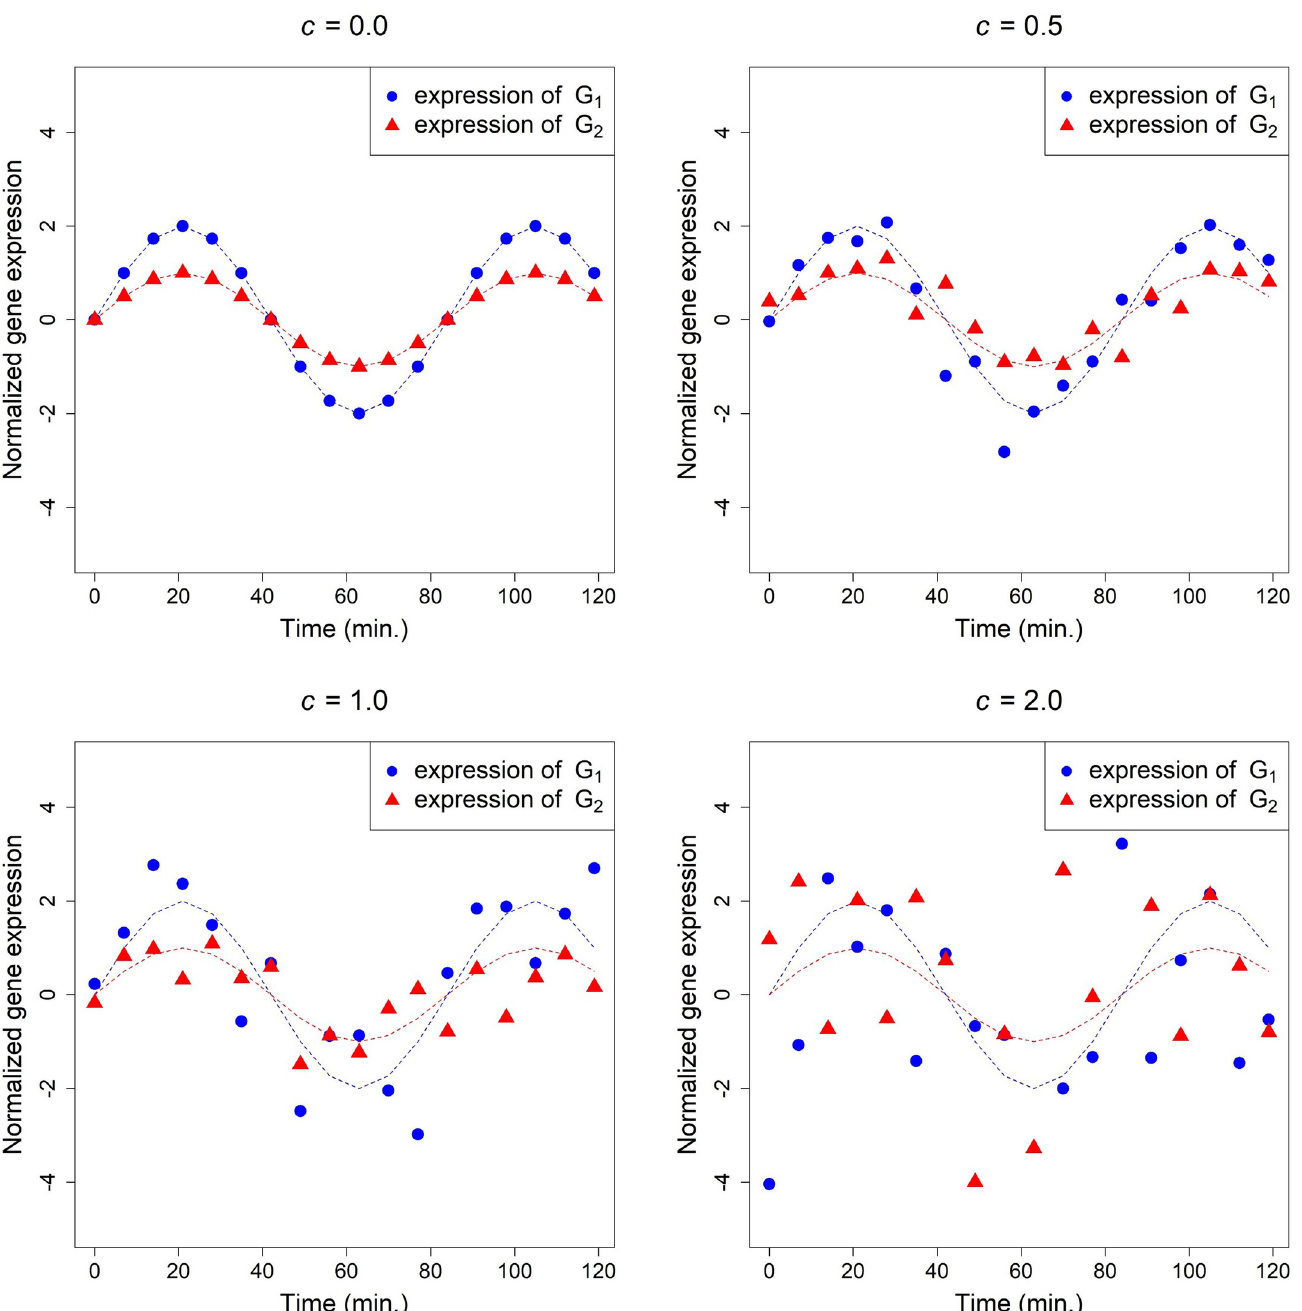
Fig 3. The simulated expression of gene G ... , 17.